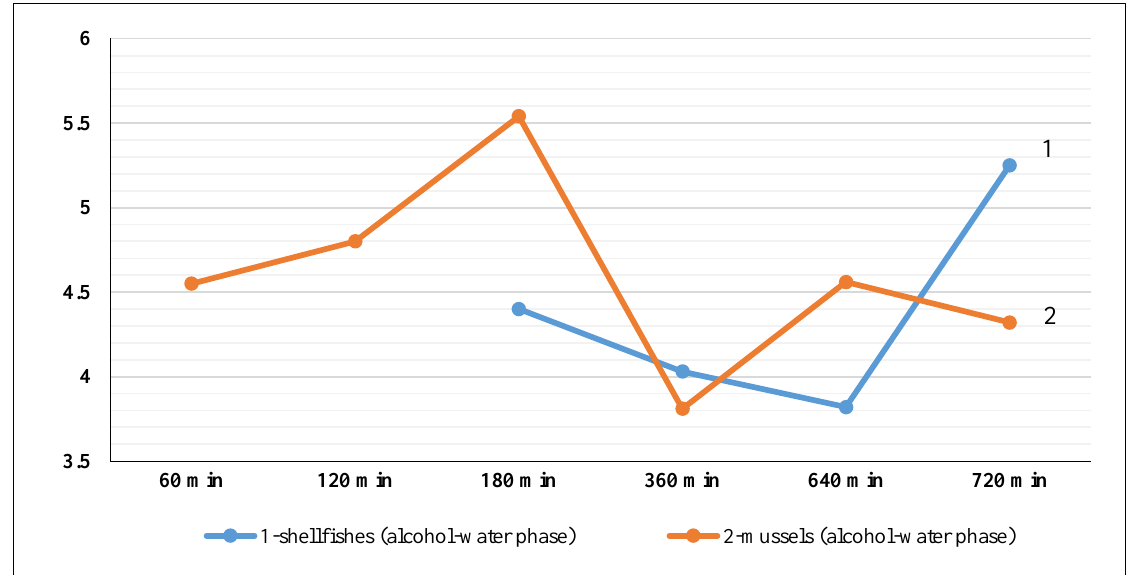
Figure 3. The antioxidative activity of BAS complexes from mussels and shellfishes in the alcohol-water phase (in terms of the amount of biologically active substances with antioxidative properties, mg/g)